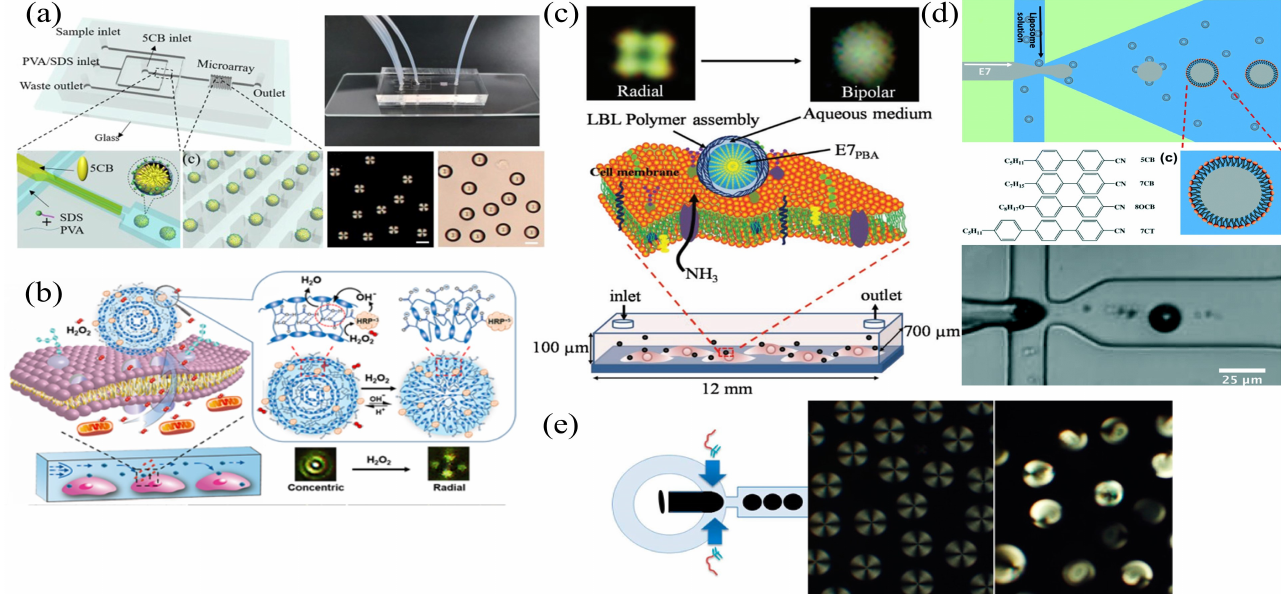
Figure 9. ( a ) Schematic of the LC droplet device for the determination of bile acids [121]; reproduced with permission from Elsevier. ( b ) Principle of configuration transformation of LCEM-HRP immo- bilized on the cell membrane based on H 2 O 2 reduction reaction [123]; reproduced with permission from Wiley. ( c ) Diagram of P − E7 PBA immobilized on cultured cells in a microfluidic channel and POM images of the transition from radial to bipolar [124]; reproduced with permission from Wiley. ( d ) Production of lipid-coated LC droplets for the detection of SMP43 according to the principle of the configuration transition in LC droplets caused by the disruption of the lipid membrane layer [125]; reproduced with permission from Royal Society of Chemistry. ( e ) LC glucose sensors were prepared by covalently bonding GOx to PAA-b-LCP functionalized LC droplets with PAA chains, and the pH change induced by GOx-catalyzed glucose oxidation underwent a radial to bipolar configuration transition through a change in the PAA chains [126]; reproduced with permission from American Chemical